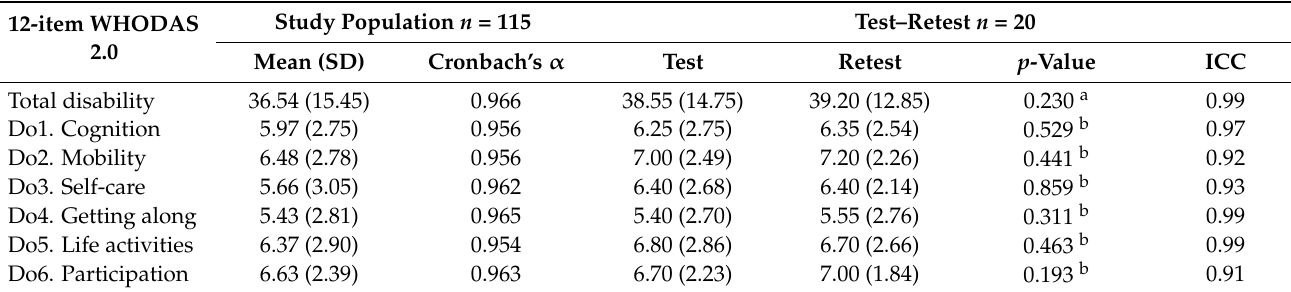
Table 2. Scale score reliability of the 12-item WHODAS